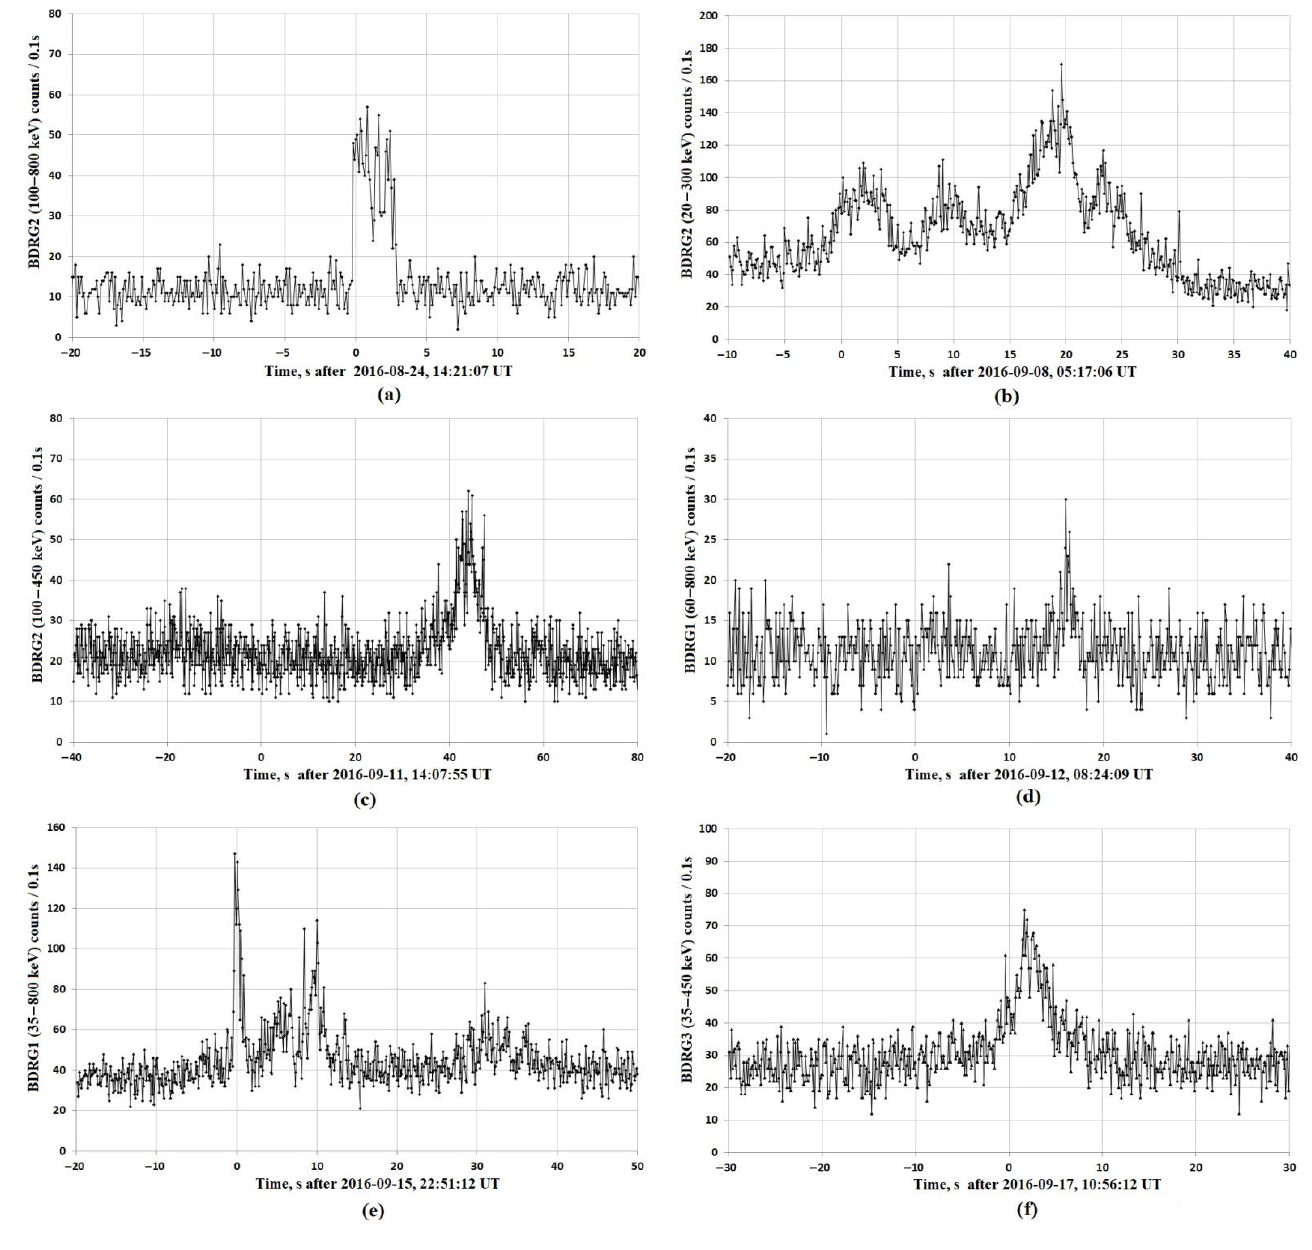
Figure 5. Light curves of BDRG/Lomonosov GRBs. ( a ) 2016 − 08 − 24, 14:21:07 UT; ( b ) 2016 − 09 − 08, 05:17:06 UT; ( c ) 2016 − 09 − 11, 14:07:55 UT; ( d ) 2016 − 09 − 12, 08:24:09 UT; ( e ) 2016 − 09 − 15, 22:51:12 UT; ( f ) 2016 − 09 − 17, 10:56:12 UT.